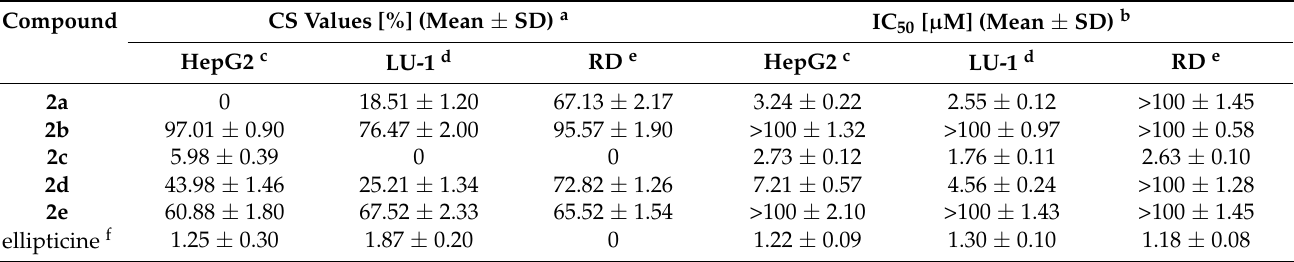
Figure 2. Oleanane-type triterpenoids found in the leaves of Aralia dasyphylla . Table 1. The cell survival values and in vitro cytotoxicity of 2a – 2e in three different cancer cell lines [35].